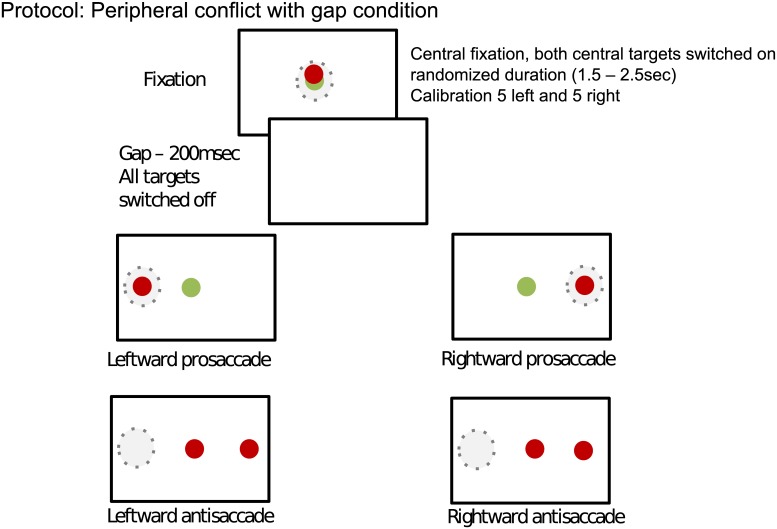
Structure of the antisaccade task.Participants first fixated on the center of the screen. Afterwards, a blank screen was presented followed by either a green or red central cue instructing participants to either make a pro or antisaccade, respectively.